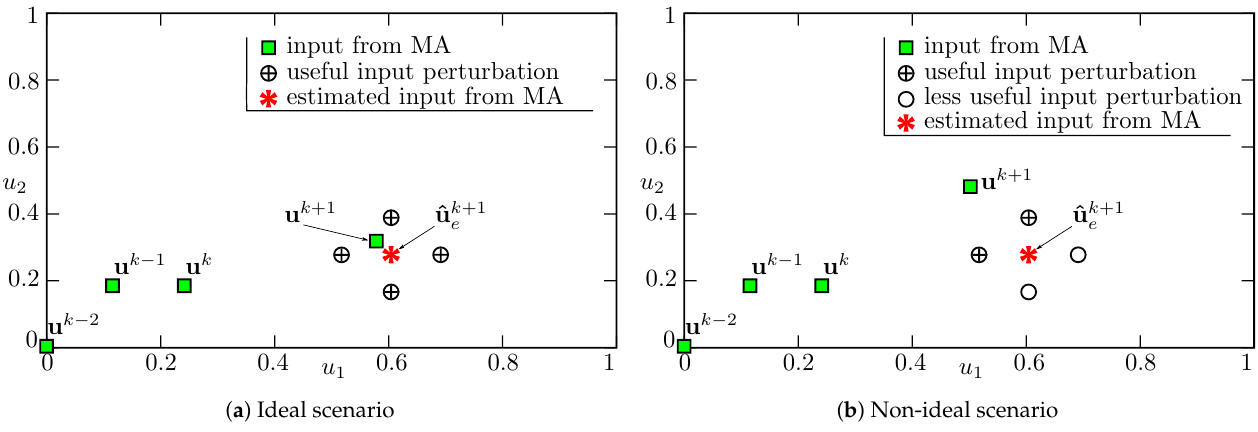
Figure 4. Illustration of active perturbation strategy with input perturbations around estimated next input (ˆ u k + 1 e ) represented by